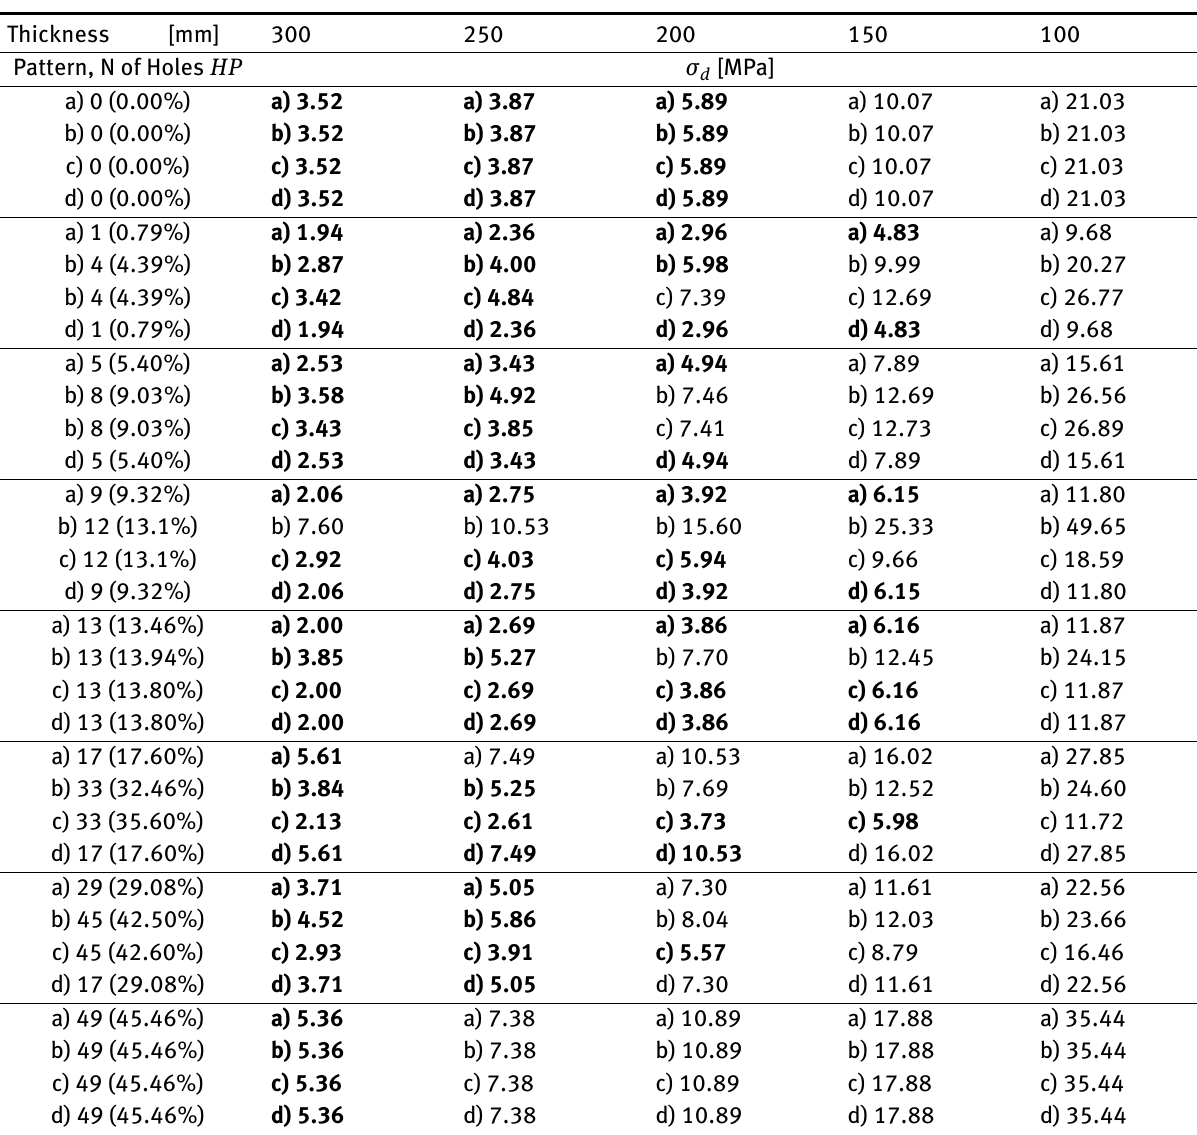
Table 2: Von Mises Stresses considering HP accretion and vault thickness ( t ). D / h = 3.2